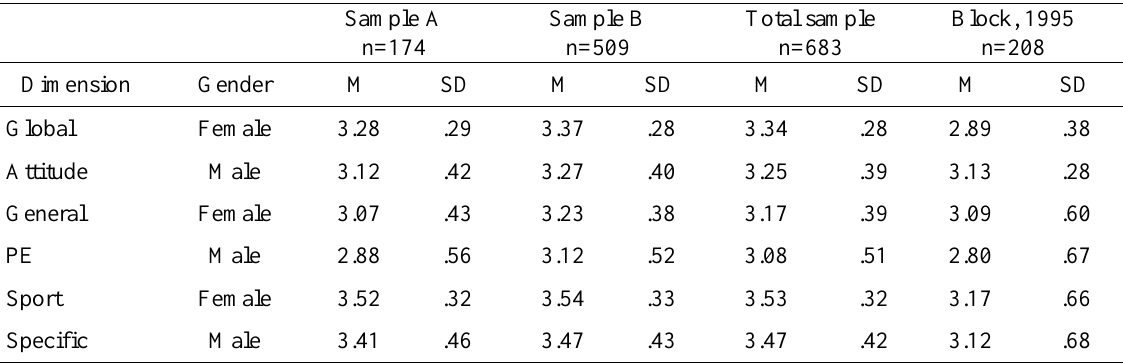
Means and standard deviations from CAIPE-R subscales analysed by gender